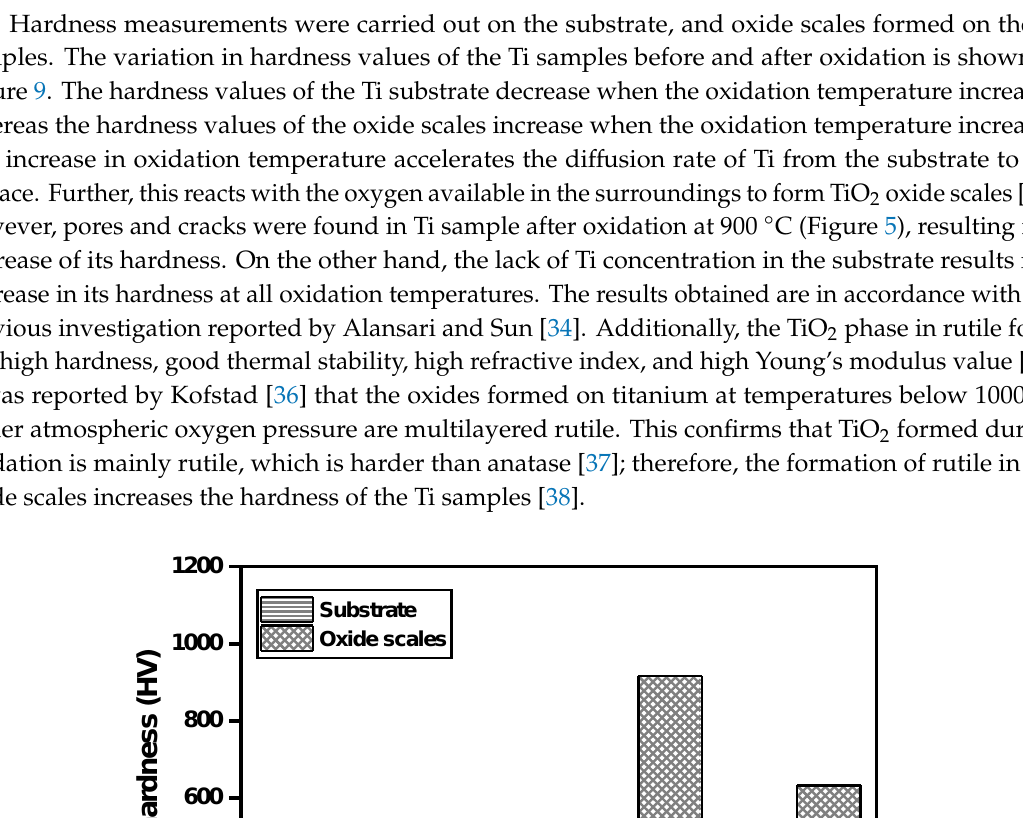
Figure 8. SEM surface morphology of the oxidized Ti at 900 ◦ C for 100 h.